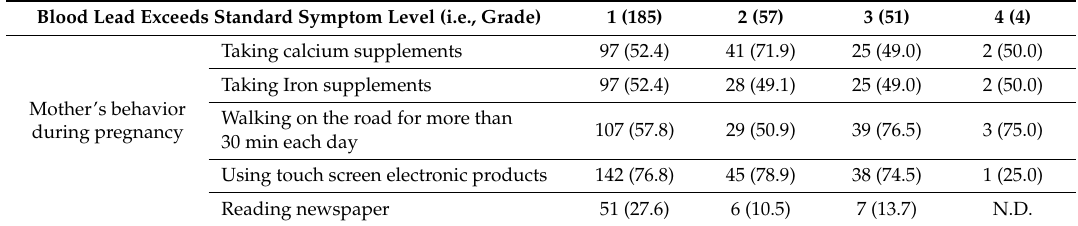
Table 12. The relationship between mothers’ behavior during pregnancy and CBL.